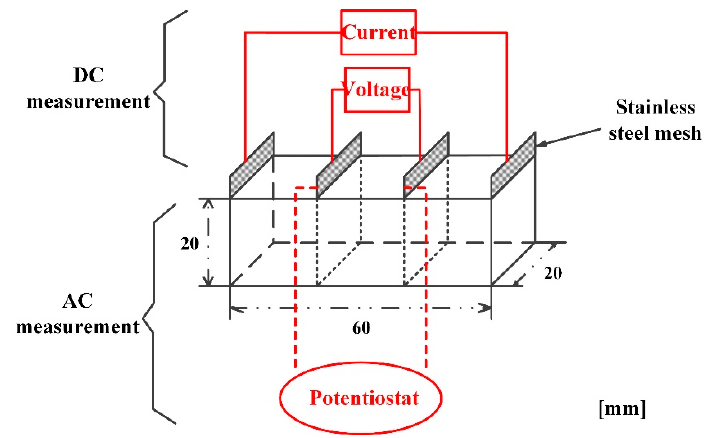
Figure 1. DC and AC measurements con fi guration.